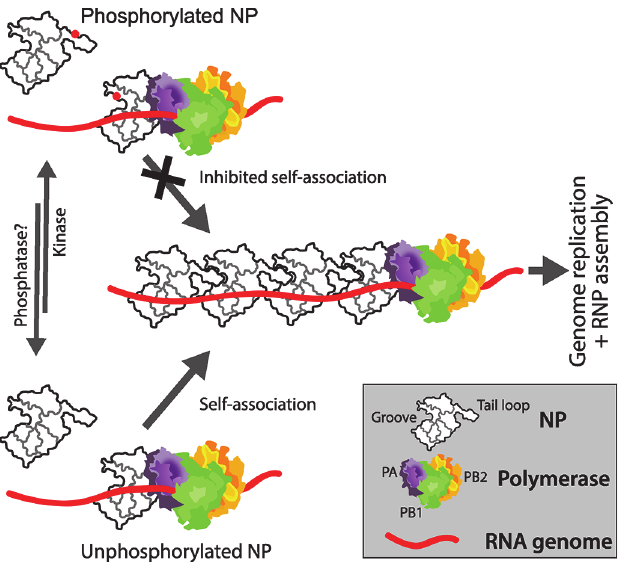
Fig 9. Mechanistic model for the regulated oligomerization of NP and RNP assembly. A portion of NP is phosphorylated by an unknown host kinase at S165 and S407 (represented as red dots), preventing tail loop: binding groove interactions and preventing self-association. Conversely, at the appropriate stage of the viral life cycle, dephosphorylation of NP by an unknown cellular phosphatase or synthesis of new NP molecules that do not get phosphorylated permits efficient self-association, genome replication, and RNP